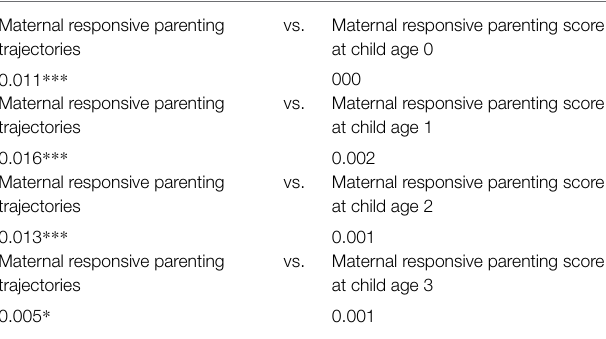
TABLE 7 | Effect sizes (Partial η 2 ): trajectories of maternal responsive parenting vs. maternal responsive parenting scores. Maternal responsive parenting trajectories